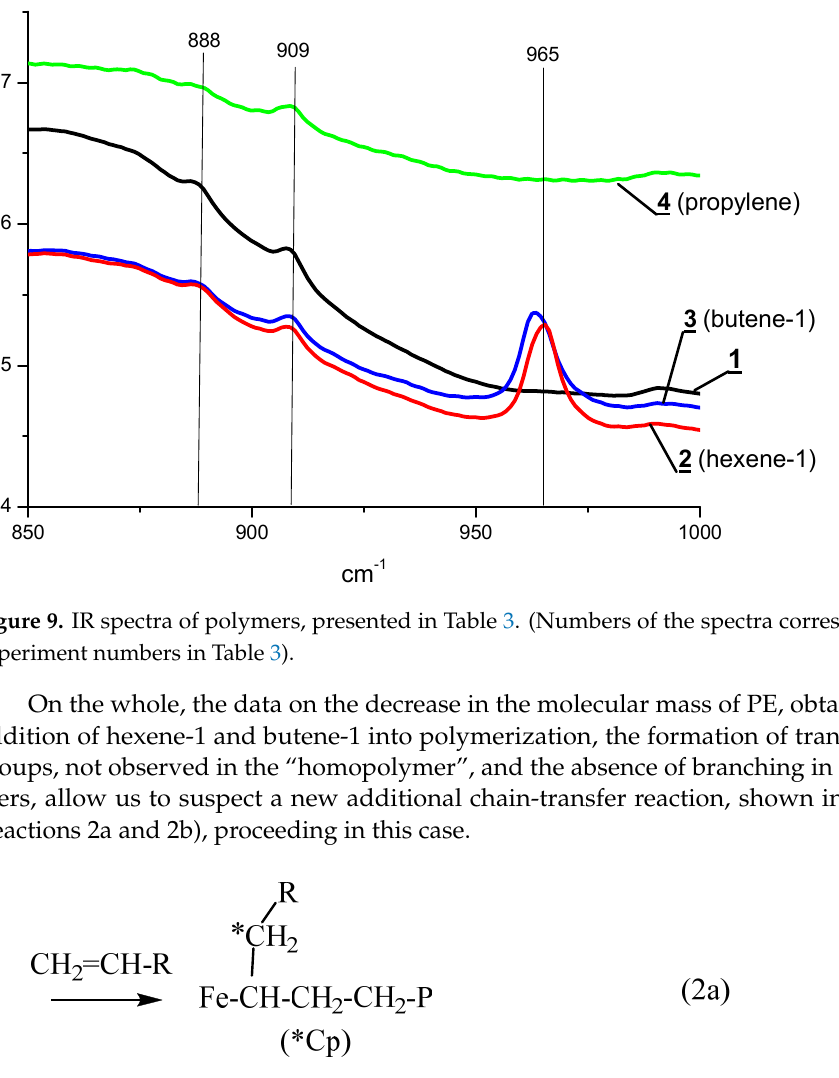
with *LFeCl 2 /MMAO catalyst during ethylene polymerization in the presence of hexene-1 and bu-